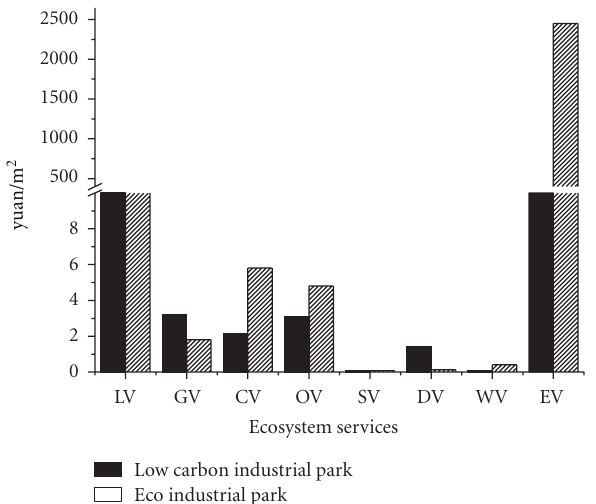
Figure 3: Comparison of the low-carbon industrial park with an ecoindustrial